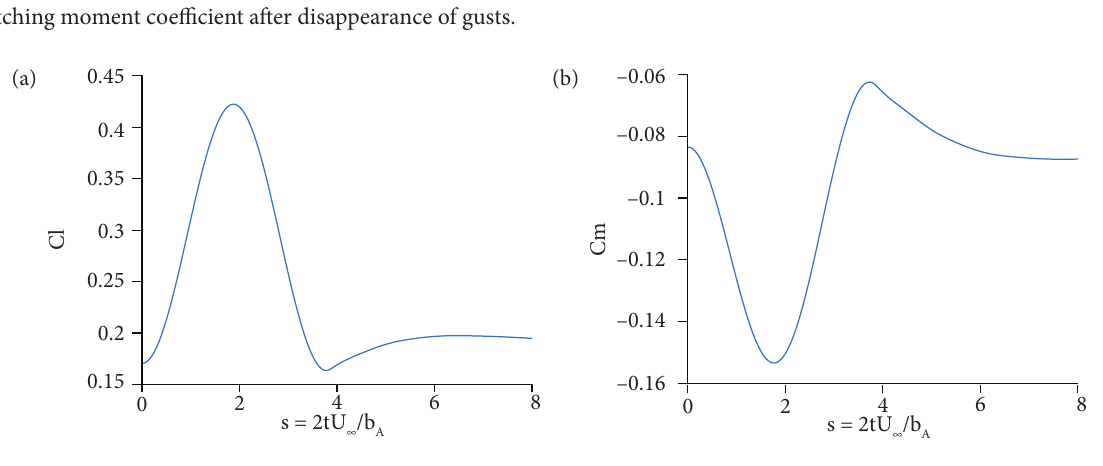
Figure 8. Response curve of longitudinal aerodynamic force lift coefficient of the UAV under 1-cos gusts.